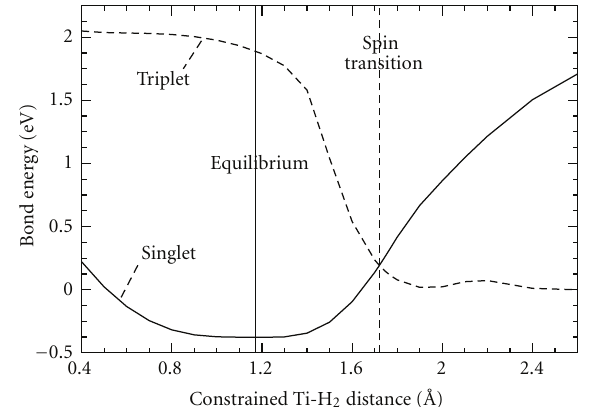
Figure 4: Total energies of the C 6 H 6 Ti[2 + 4]-H 2 complex for di ff erent constrained Ti-H 2 distances, measured from Ti to the center of mass of H 2 . H 2 approaches perpendicular to the z -axis, lying along the x -axis (in the direction of the 2C atoms of the [2 + 4] structure). The triplet and singlet states (dashed and straight line, resp.) are compared. Vertical lines indicate the equilibrium distance of 1.12 ˚A (straight line) and the transition point at 1.72 ˚A (dashed line). All energies are relative to the value of the triplet curve at large distance we indicated as